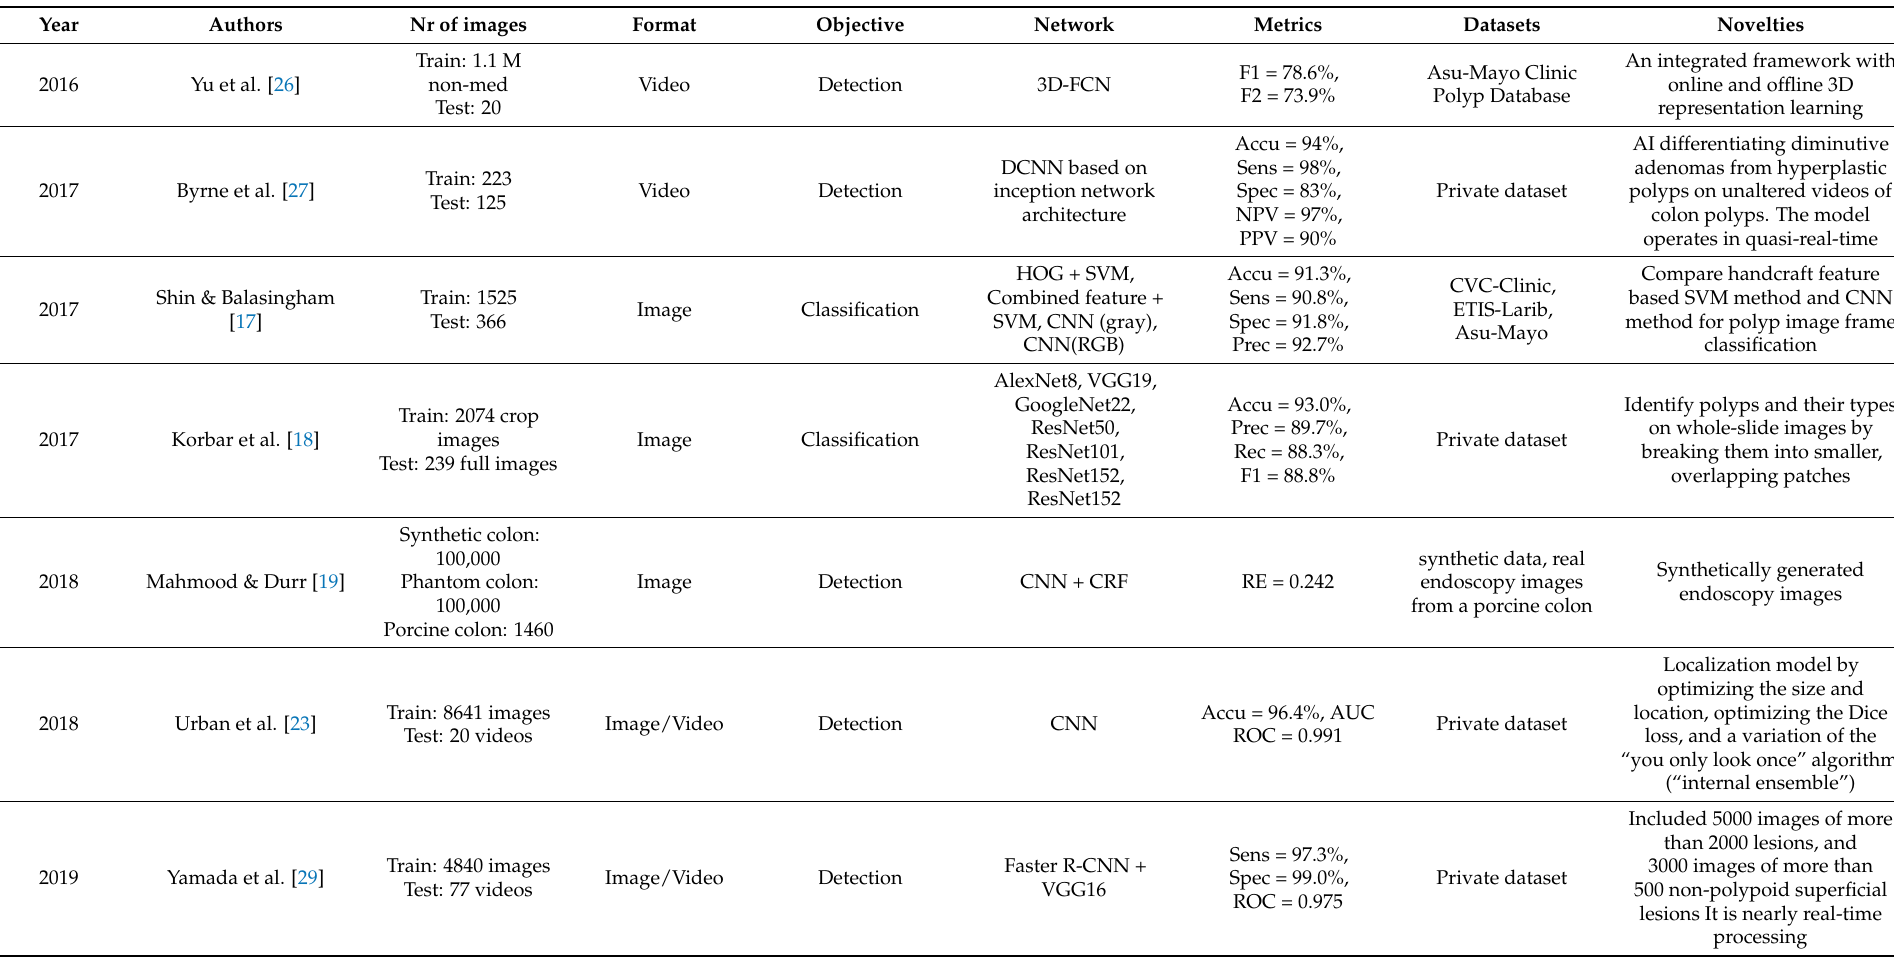
Table 1. Summary of the reviewed